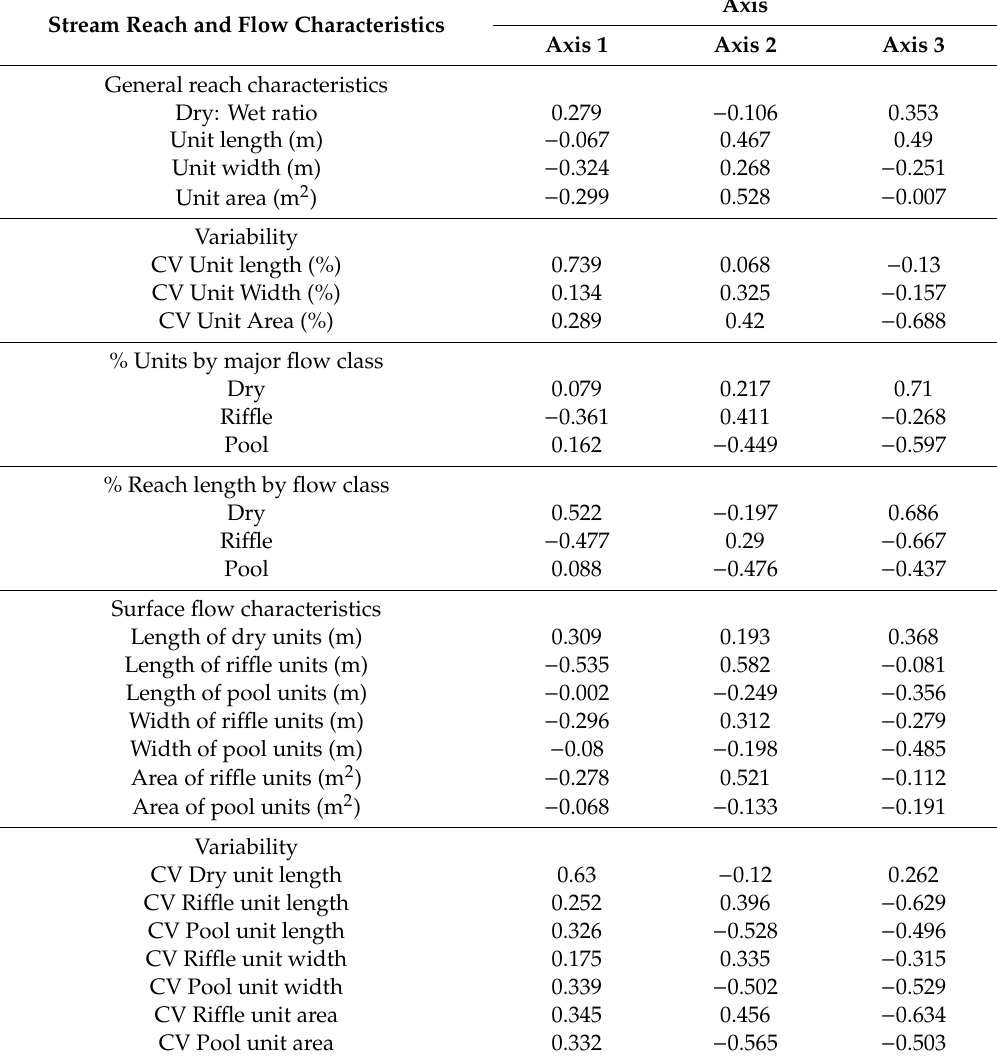
Table 4. Pearson correlations between stream reach characteristics (average values unless otherwise indicated) and axes from non-metric multidimensional scaling ordination of 65 reaches (see Figure 5). sites measured repeatedly over time from 1995–2011 (Table 1). Correlation values ( r ) ≥ 0.11 are statistically significant (two-tailed test, p < 0.05). CV = coe ffi cient of variation. Stream Reach and Flow